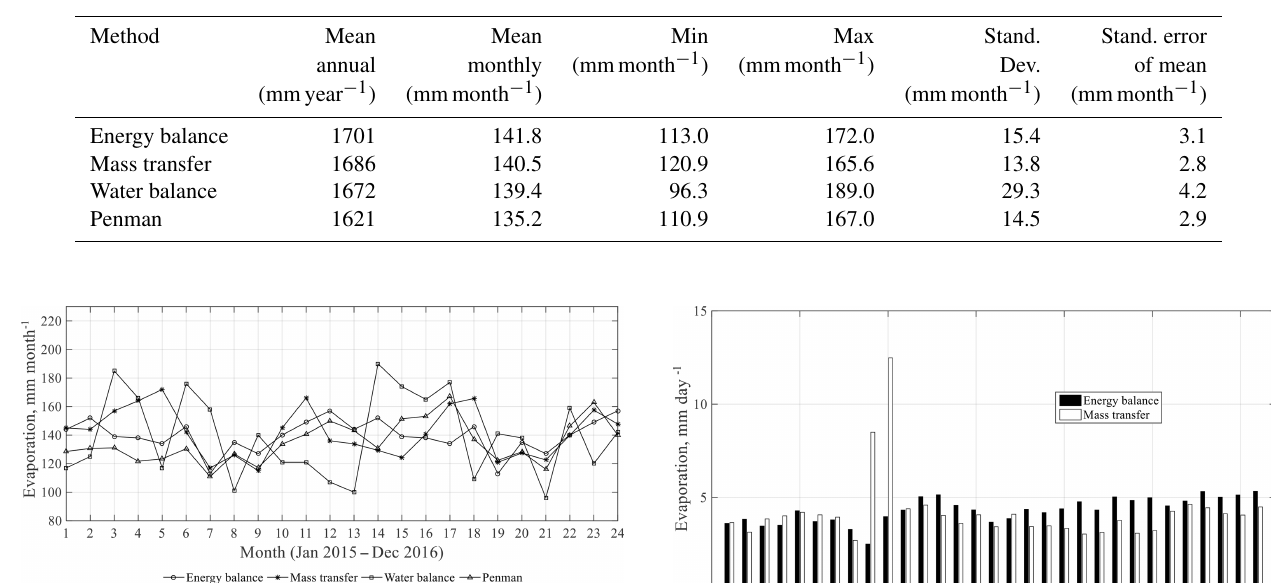
Table 5. Descriptive statistics of monthly evaporation calculated by the four methods for the period from January 2015 to December 2016.